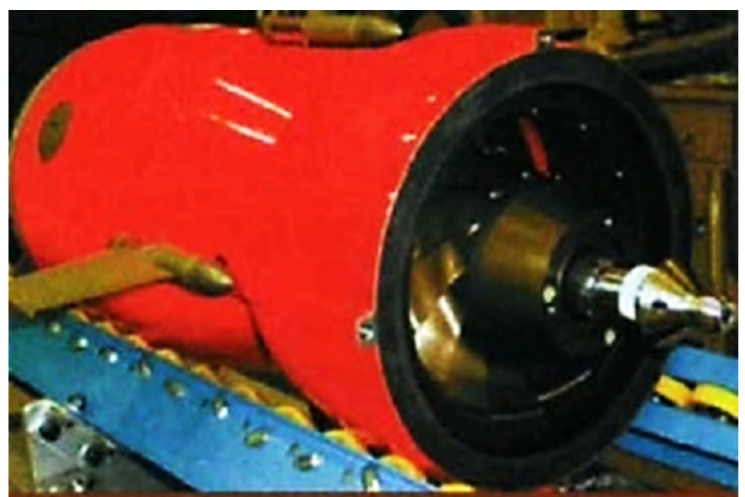
Figure 3. Prototype of integrated motor propulsion developed by the U.S. Navy [8].